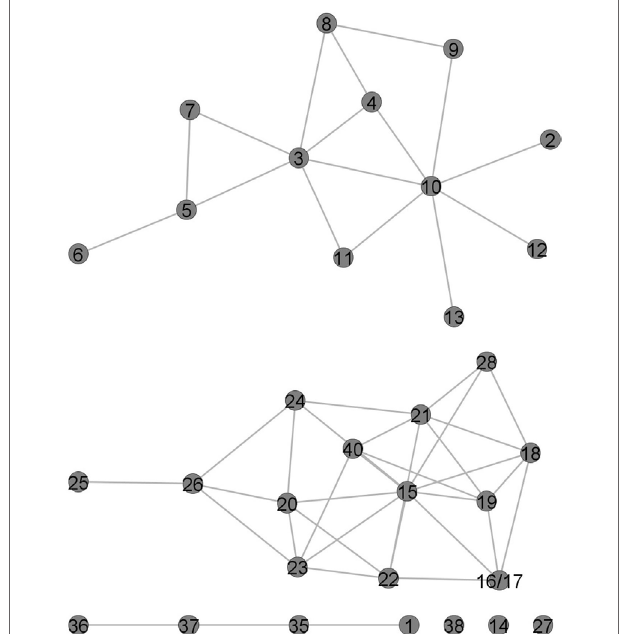
FigUre 11 | Subnetwork at the center of the Cranborne Chase study area of the visibility network of long barrows by Tilley (1994) (Fig.